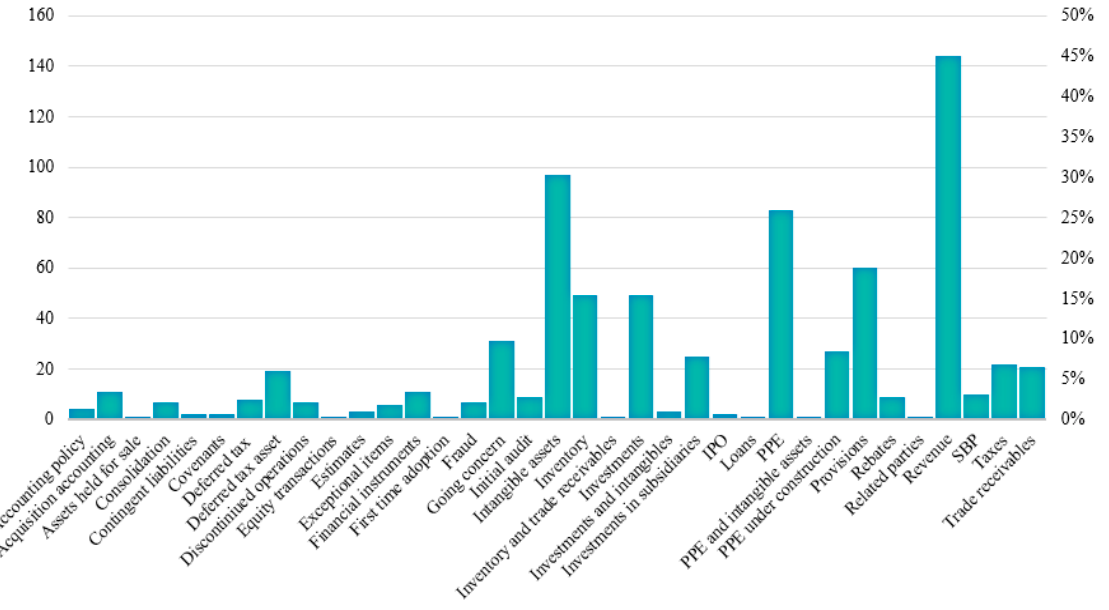
Figure 5. KAM—number and frequency of use. Source: own elaboration based on analyzed data.